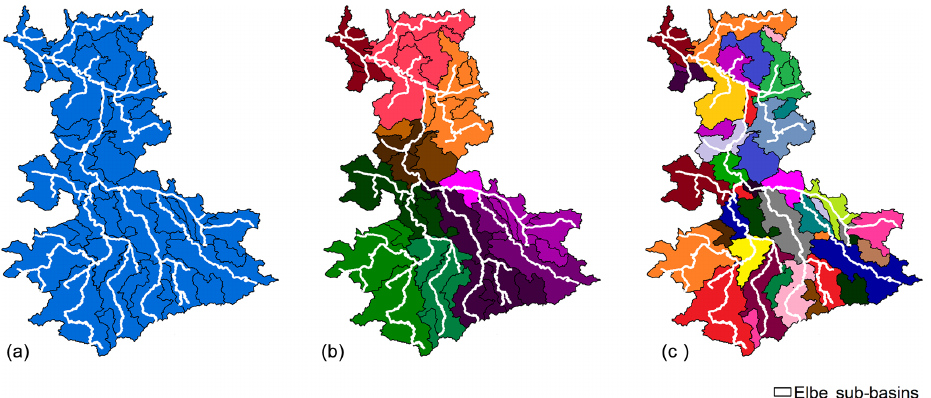
Figure 3. Conceptual representation of the three assumptions on spatial dependence: (a) complete dependence, (b) modelled dependence and (c) complete independence. Return periods of damage are colour-coded at the sub-basin